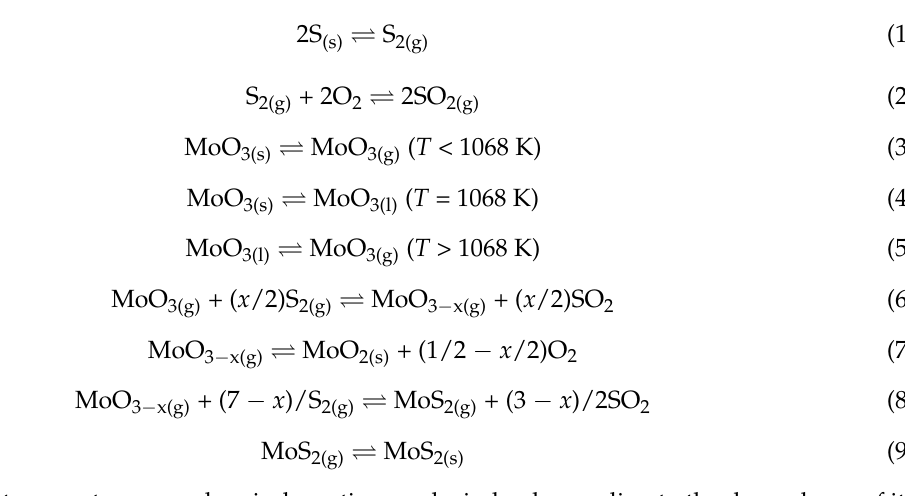
Figure 4. Dependence curve of the standard Gibbs free energy change ( ∆ G 0 ) on temperature ( T ) for the chemical reaction. ( a ) Positive slope ( ∆ S 0 < 0); ( b ) negative slope ( ∆ S 0 > 0).